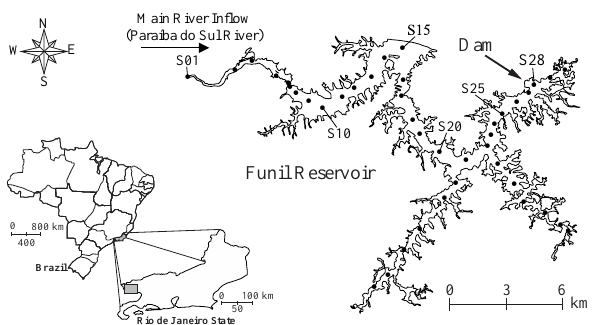
Figure 1. Map of the Funil Reservoir showing the geographic loca- tion and sampling